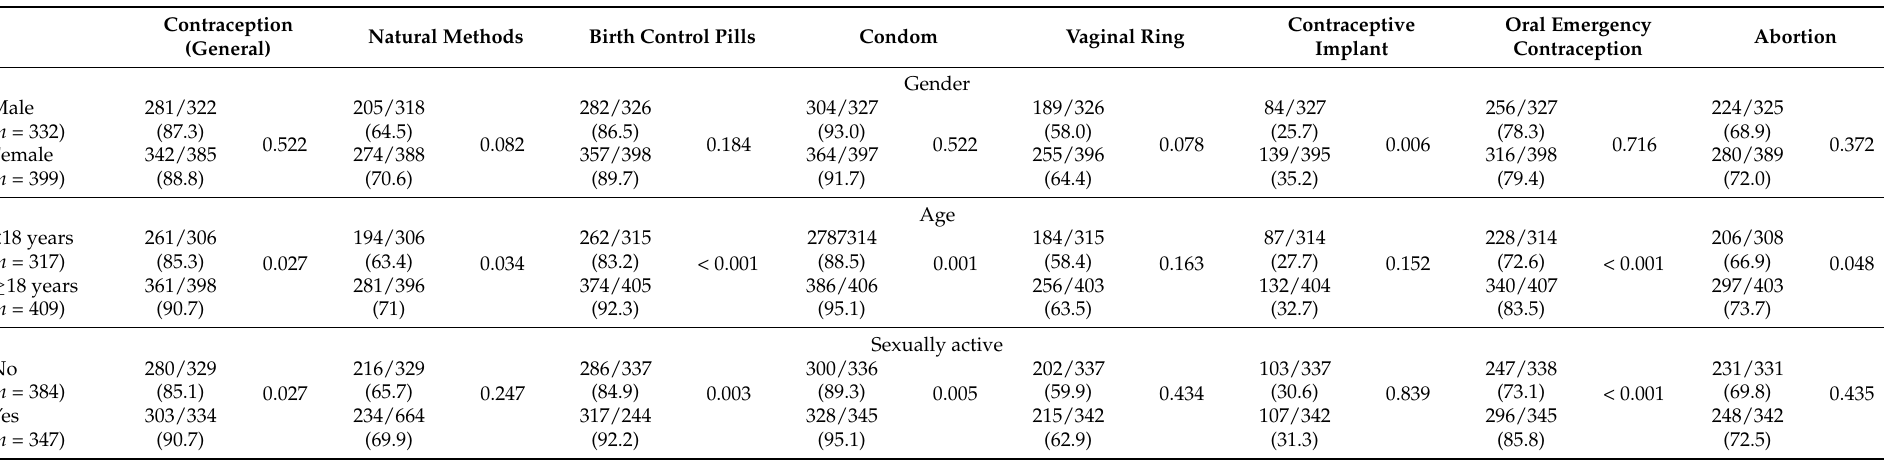
Table 3. General and particular knowledge about contraception by sex, age, and being sexually